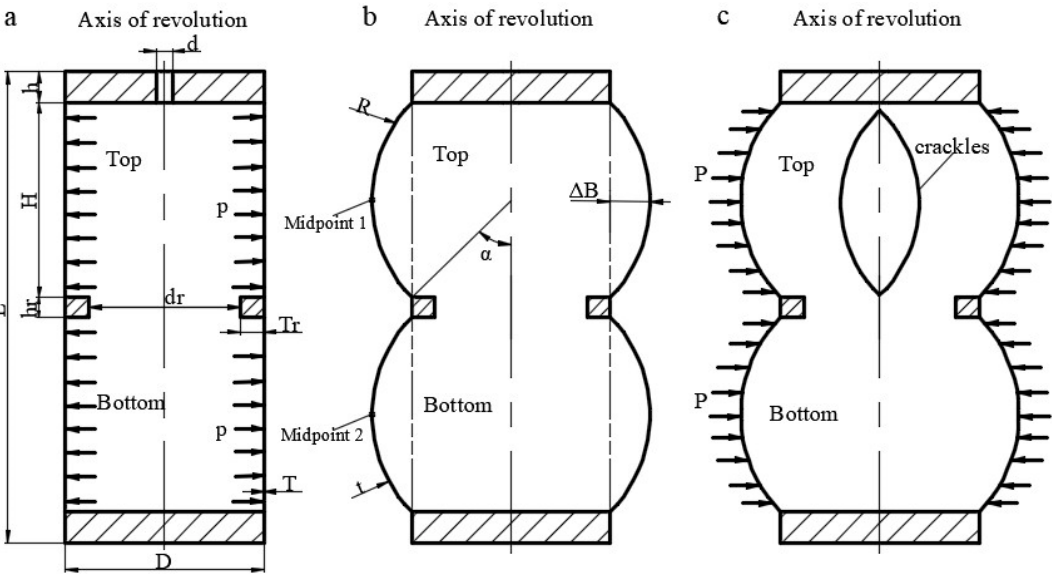
Figure 1. Schematic of a bi-segment cylindrical preform ( a ), bulged hull ( b ), and collapsed hull ( c ). For each bi-segment cylindrical preform, the optimal thickness of the hoop rib could be found. In general, if the meridian of the bi-segment pressure hull has not exceeded a spherical shape, then the shell and hoop are displaced uniformly under external